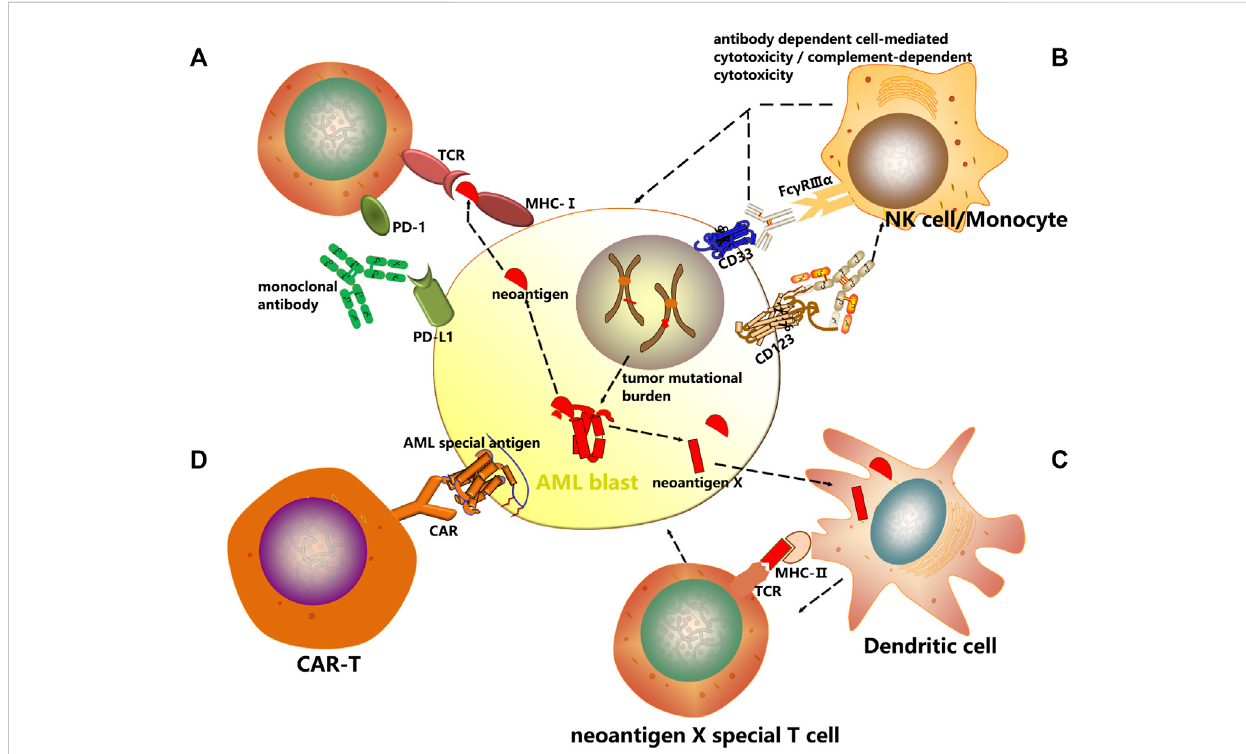
FIGURE 1 Mechanisms of cancer immunotherapy. In this review, several immunotherapeutic strategies have been discussed with an emphasis on AML treatment. (A) Checkpoint inhibitors are a new class of immunotherapy that use monoclonal antibodies to modulate inhibitory receptors on T cells to enhance T cell-mediated immune responses. (B) The antibody dependent cell mediated cytotoxicity (ADCC) and complement dependent cytotoxicity (CDC)inducedbyAMLsurfaceantigen-directedantibodies,aswellastheeffectofaninternalizedantibody-toxinconjugateresultinAMLcelldeath. (C) Dendriticcells are unique antigen-presenting cells (APC) and comprise the main class of APC. Autologous CD14 + monocytes derived from peripheral blood of cancer patients are differentiated with GM-CSF and IL-4/IL-13 into immature DCs in vitro . Thereafter immature DCs are supplied with tumor antigens, that is, whole cell lysates, tumor-associated antigens (TAAs) or neoantigens. These antigen-loaded DCs are further matured and then enhance vaccine-induced immune responses. (D) Chimeric antigen receptors (CARs) are genetically modi fi ed receptor proteins with both extracellular antigen binding domain and intracellular signaling domain. With their unique structure, particularly effective cytotoxic activity, as well as antigen binding in an MHC-independent fashion is